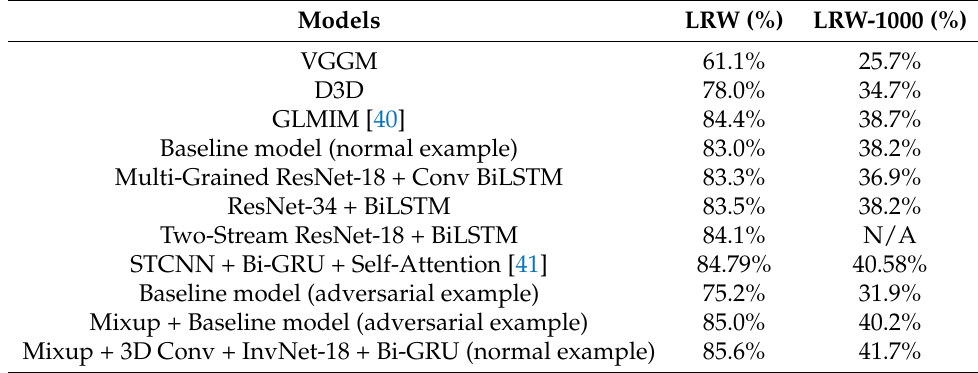
Table 4. Comparison with other